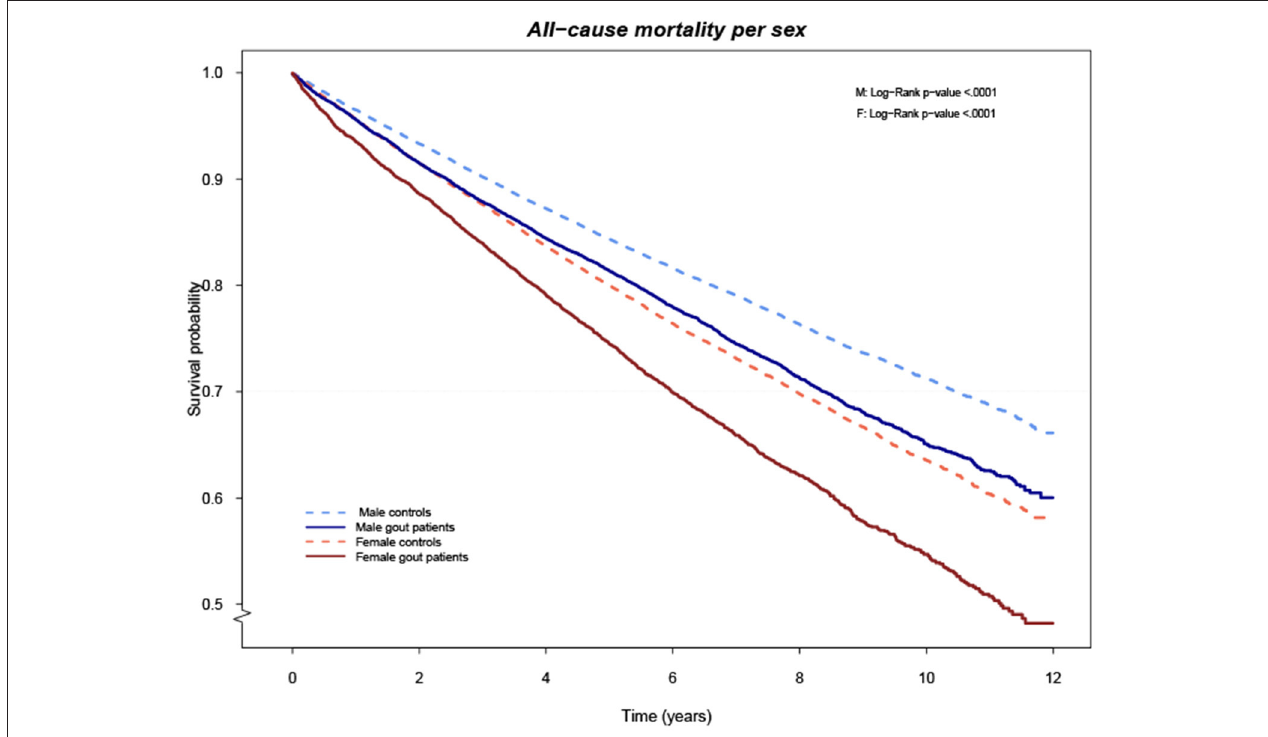
FIGURE 1 | Cumulative risk of death overall comparing cases and controls stratified by gender.